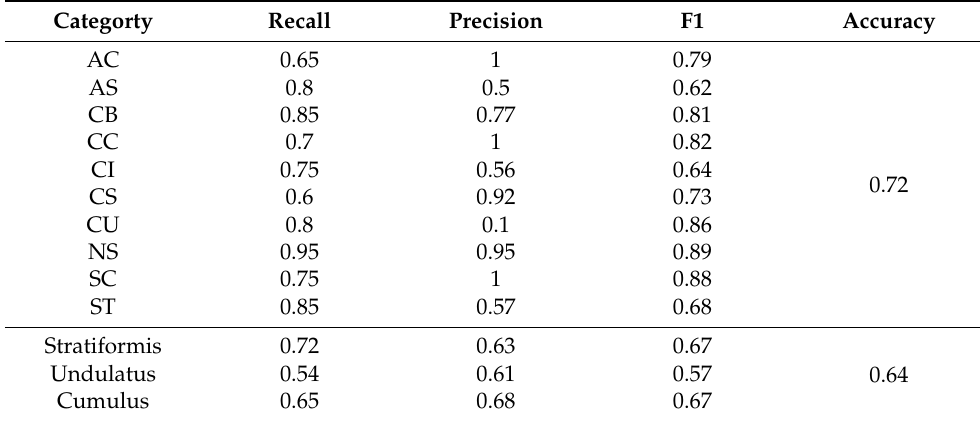
Table 4. Performance evaluation of Sobel datasets with multiple classification